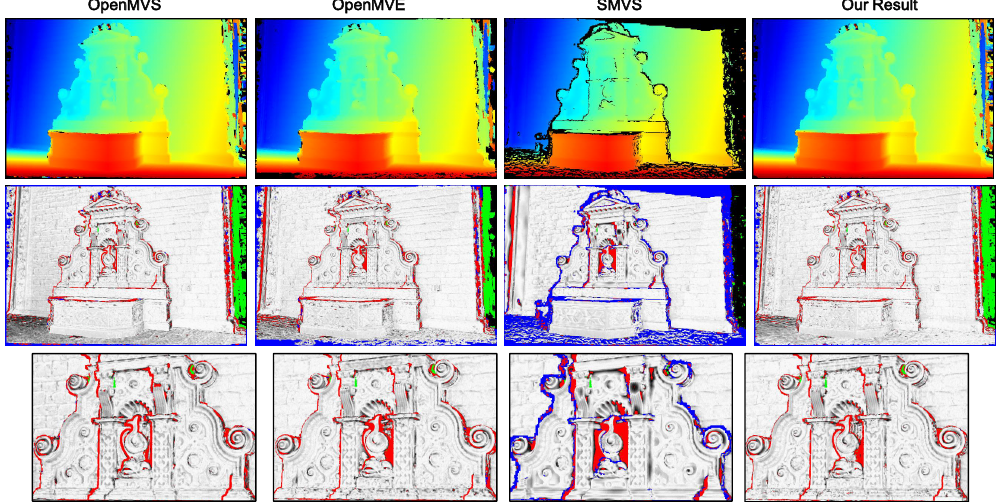
Figure 10. Colorized depth maps and visualized (relative) depth errors defined as e rel = e abs / GT (GT denotes the ground truth depth) on Fountain-P11 . From left to right: the top row displays the estimated depth map from MVS, MVE, SMVS and our method respectively; the middle and bottom rows demonstrate the per-pixel relative depth errors with blue pixels encoding missing depth data, green representing extra estimated depth values and red denoting those pixels with e rel larger than 0.01. The pixels with e rel below 0.01 are linearly converted to gray values, where the integer 255 (highest brightness) corresponds the zero deviation.